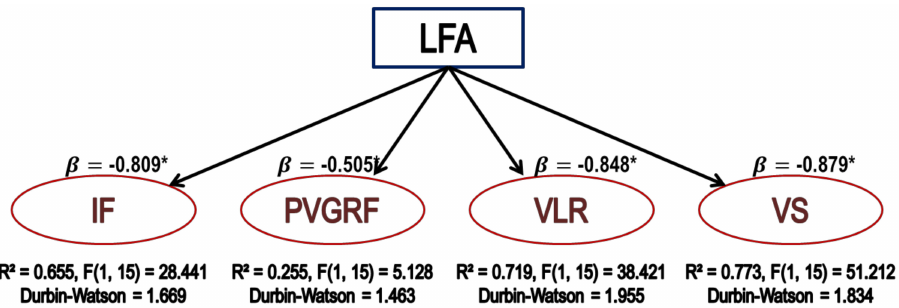
Figure 4. Description of the effect of the LFA on IF, PVGRF, VLR, and VS. * indicates statistical